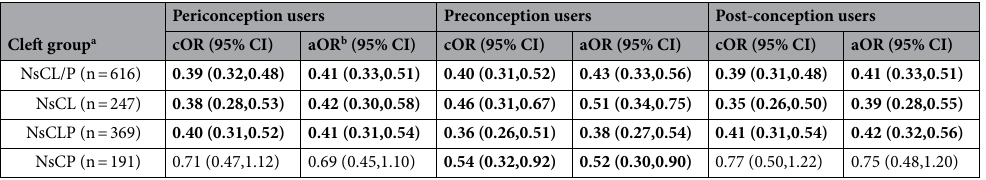
Table 3. The associations between maternal peri-conceptional folic acid supplementation and nonsyndromic orofacial clefts. NsCL/P, nonsyndromic cleft lip with or without cleft palate cases; NsCL, nonsyndromic cleft lip cases; NsCLP, nonsyndromic cleft lip with cleft palate cases; NsCP, nonsyndromic cleft palate cases. Bold values are statistically significant at α = 0.05. a There were 8070 controls. b Adjusted for maternal age, maternal education, urban–rural classification, residence, parity, medical condition and environmental exposure in the first trimester, maternal BMI, and infant